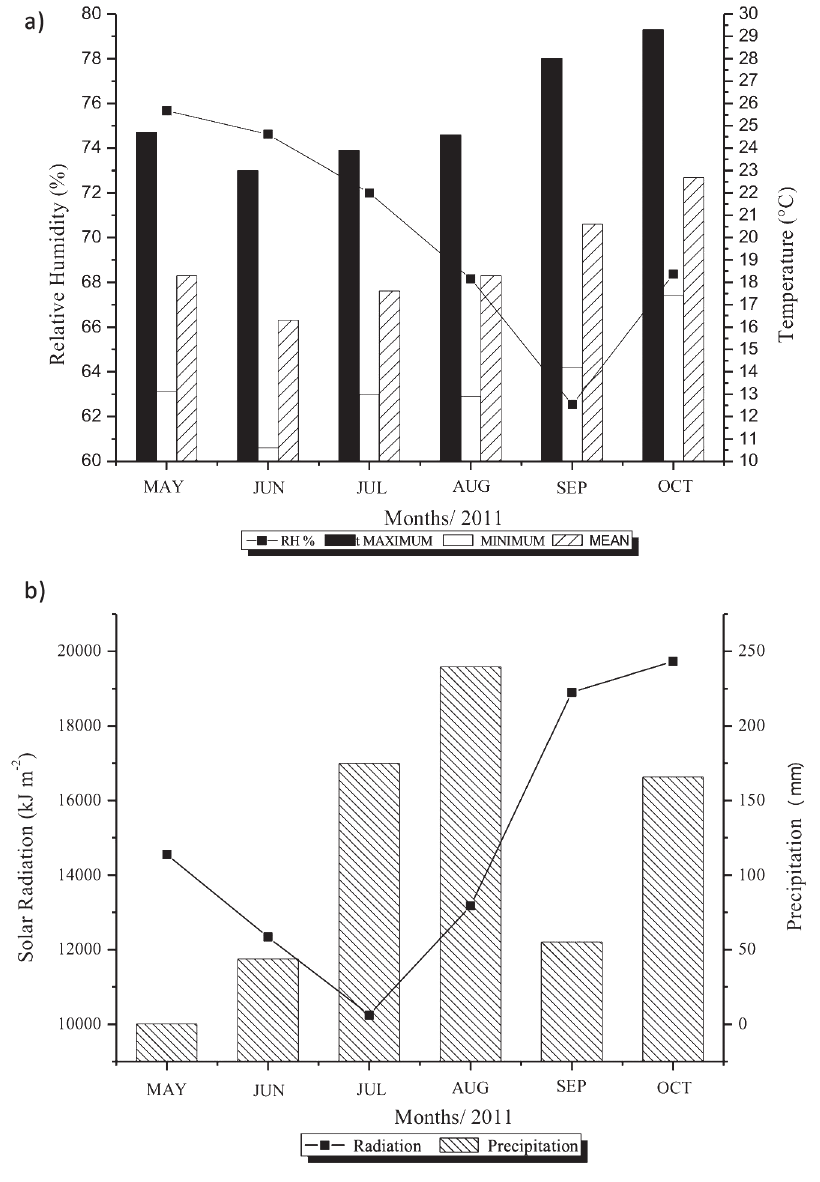
Fig. 1 - Environmental conditions for the period May-October 2011 in the experimental area at the municipality of Marechal Cândido Rondon (state of Paraná, Brazil). (a) RH (%) – relative humidity, maximum, minimum and mean temperature (°C). (b) Rainfall (mm) and solar radiation (kJ·m 2